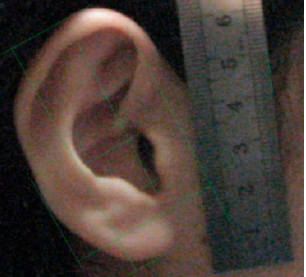
Figure 8. Measurement sketch for ear and head features.